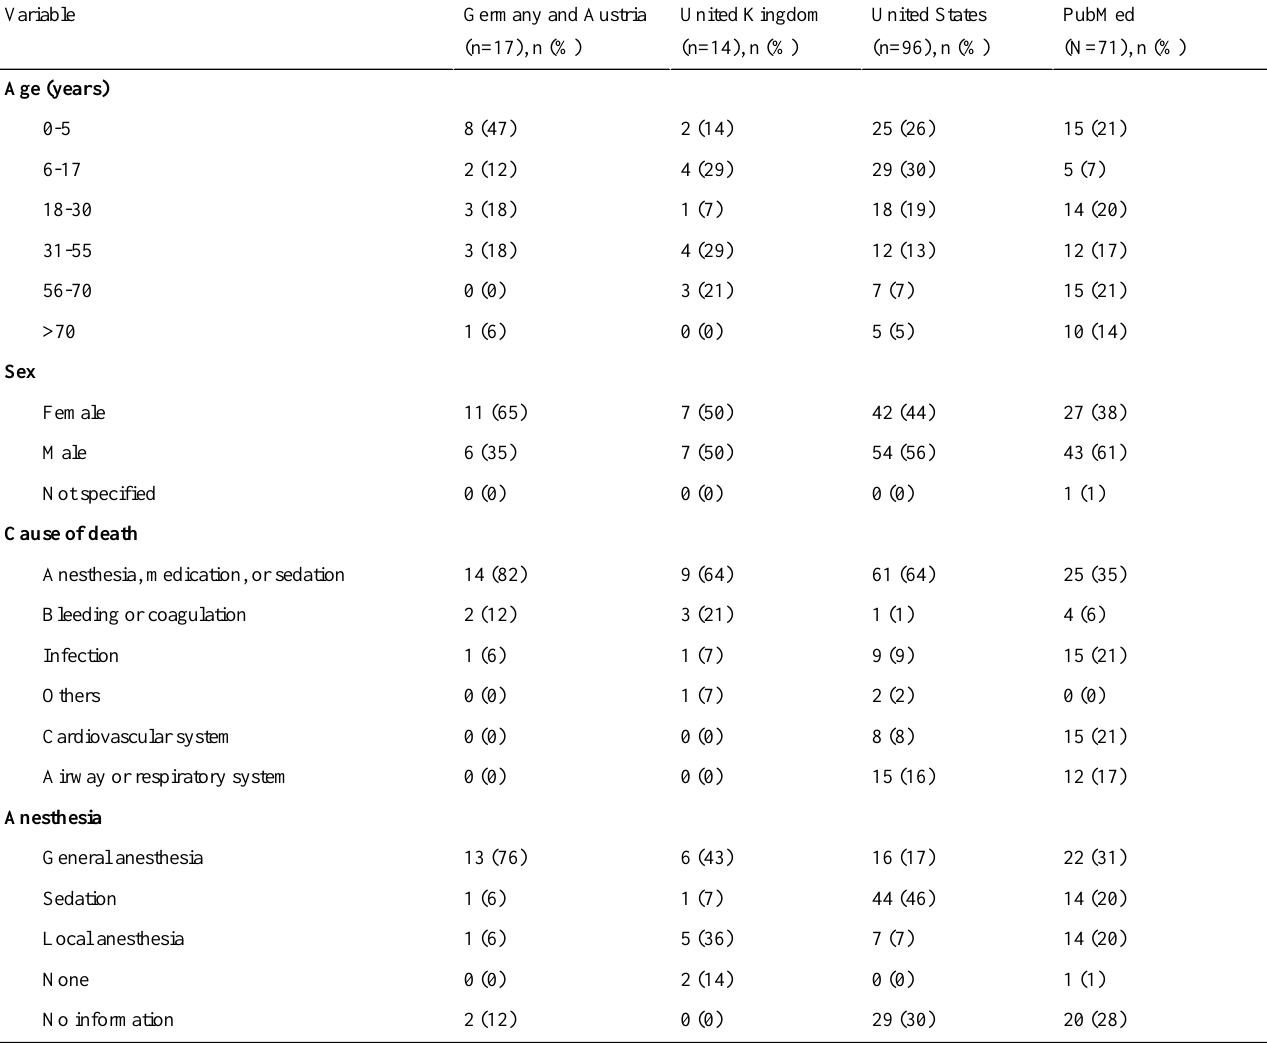
Table 5. Age and sex of casualties, cause of death, and anesthesia used in dental facilities found in online publications from three country groups compared with the PubMed